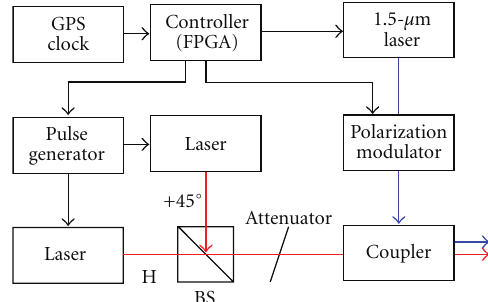
Figure 6: Configuration of transmitter (Alice).